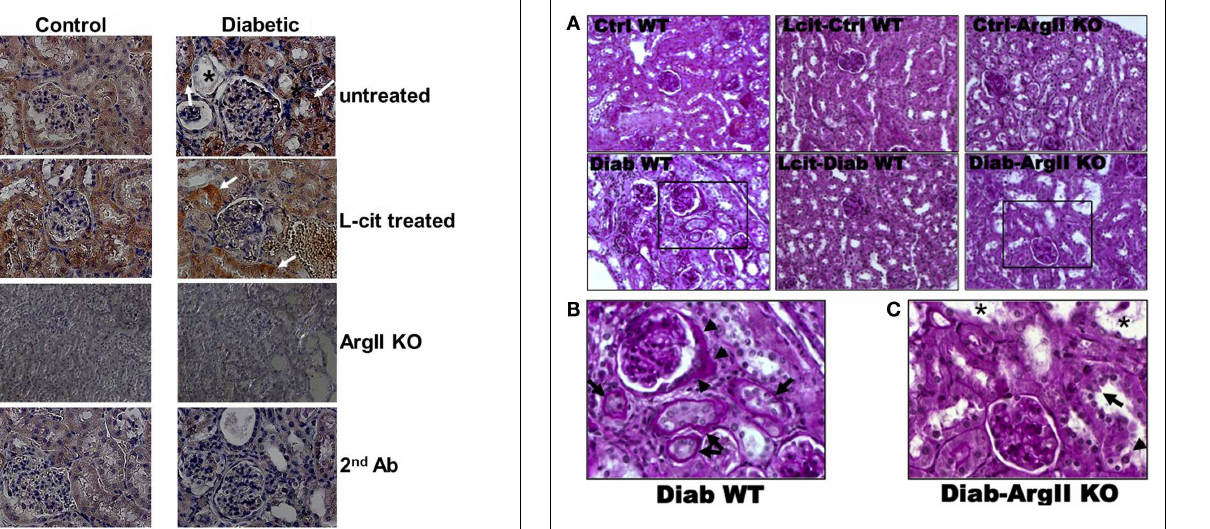
FIGURE 2 | Immunohistochemistry ofArgII in paraffin-embedded mouse kidney sections . Representative photographs of paraffin-embedded kidney sections showing immunolocalization of ArgII (brown color; 40 × immersion oil). (A) Cortical tubular segments in untreated diabetic mice show higher stain density than untreated control mice, after 16weeks (white arrows). Atrophic tubules with widened lumina and flattened tubular cells, or with altered epithelial morphology, show reduced ArgII staining (*). L -Cit-treated diabetic mice show also enhanced ArgII stain intensity (white arrows). Kidney segments of control and diabetic ArgII knock out mice (B) , or tubules stained with secondary antibody alone (C) were completely negative for ArgII immunostaining.